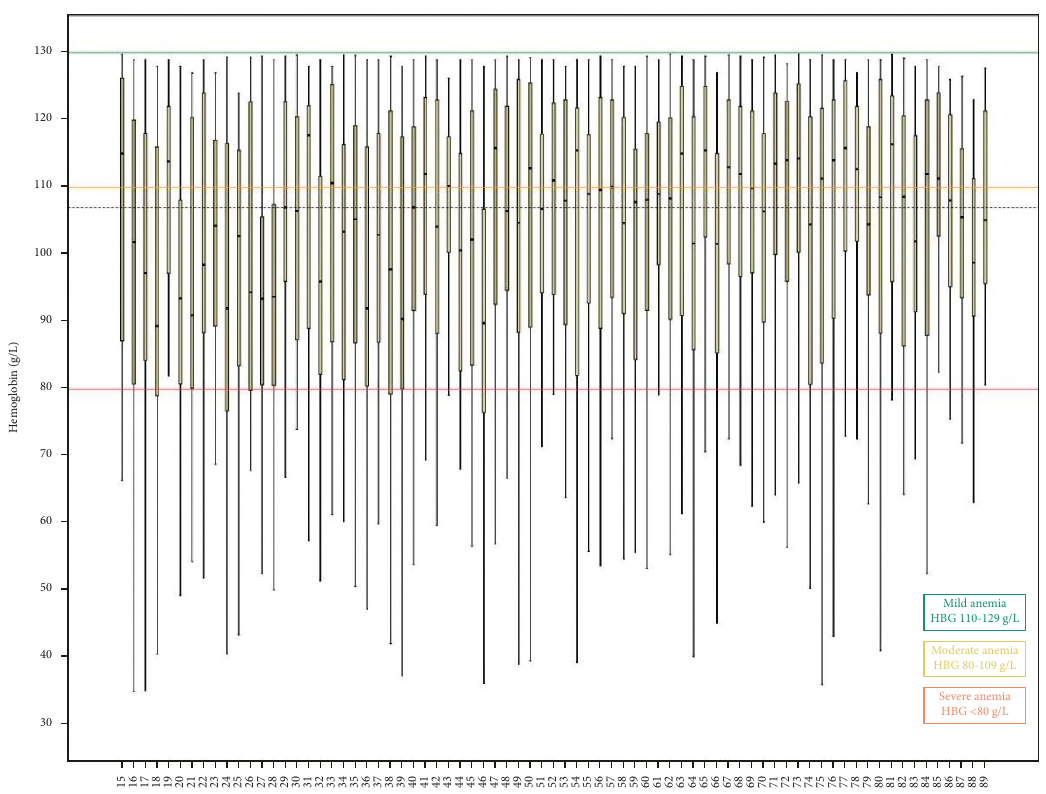
Figure 2: Anemia groups stratified based on hemoglobin concentration for male gender and